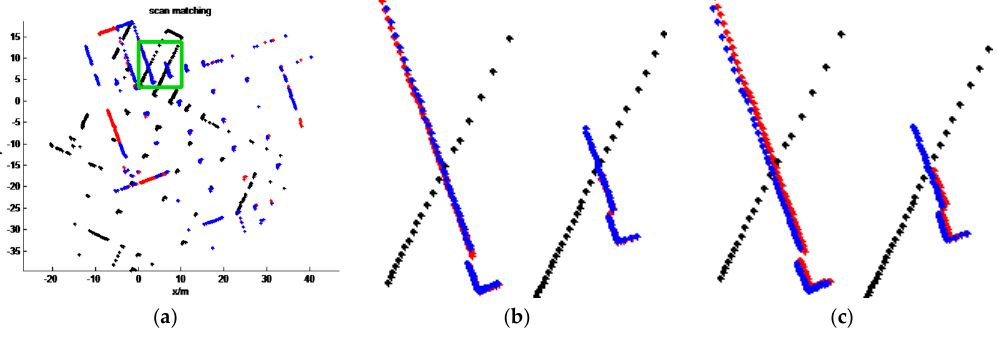
Figure 11. The enlarged result of scan pair 3 of dataset 1. ( a ) The green box is the enlarged region; ( b ) the enlarged results of our method; ( c ) the enlarged results of ICP 2 . Table 1. Quantitative evaluation on dataset 1.